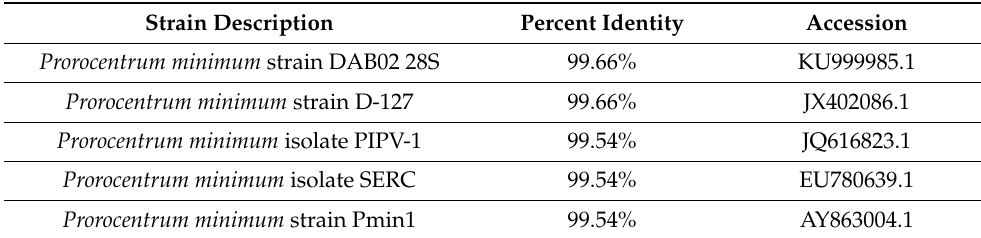
Table 2. Top 5 BLAST nucleotide sequence hits of the LSU rRNA sequence of Prorocentrum minimum from Berowra Creek, CAWD359, as compared with sequences of P. minimum strains on the NCBI database, including linked accession numbers.